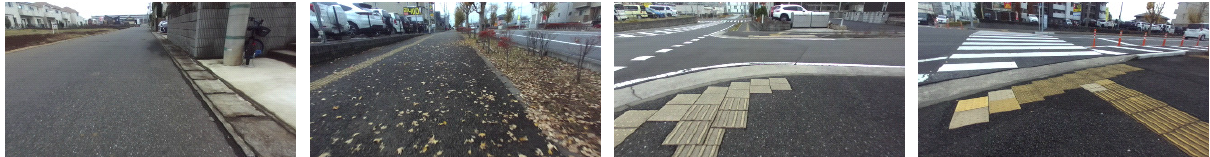
Figure 6. Experimental vehicle and sensor mounting position.